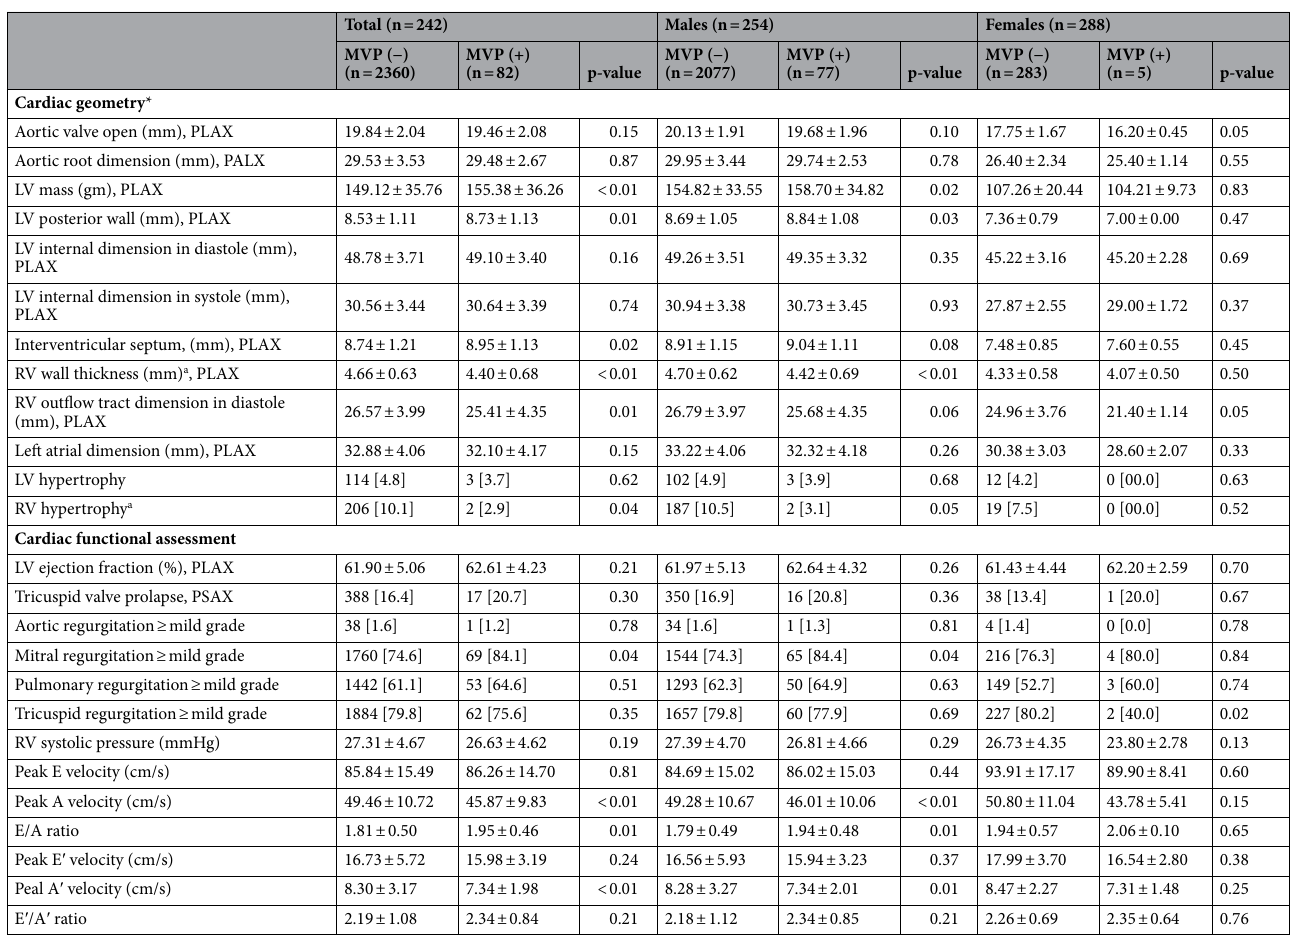
Table 2. Echocardiographic findings of young male and female participants with mitral valve prolapse and those without. Continuous variables are expressed as mean ± SD (standard deviation), and categorical variables as N [%]. BSA body surface area, LV left ventricle, RV right ventricle, PLAX echocardiographic parasternal long axis view, PSAX echocardiographic parasternal short axis view a N = 2102 in total (N = 1842 for males and N = 260 for females). *indicates the p-value for the echocardiographic geometry variables with adjustment for body surface